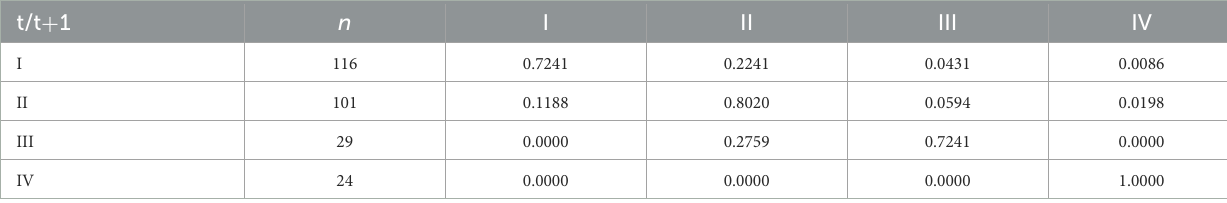
TABLE 5 Markov transfer probability matrix for tourism ecosystem health types in China from 2011 to 2020.